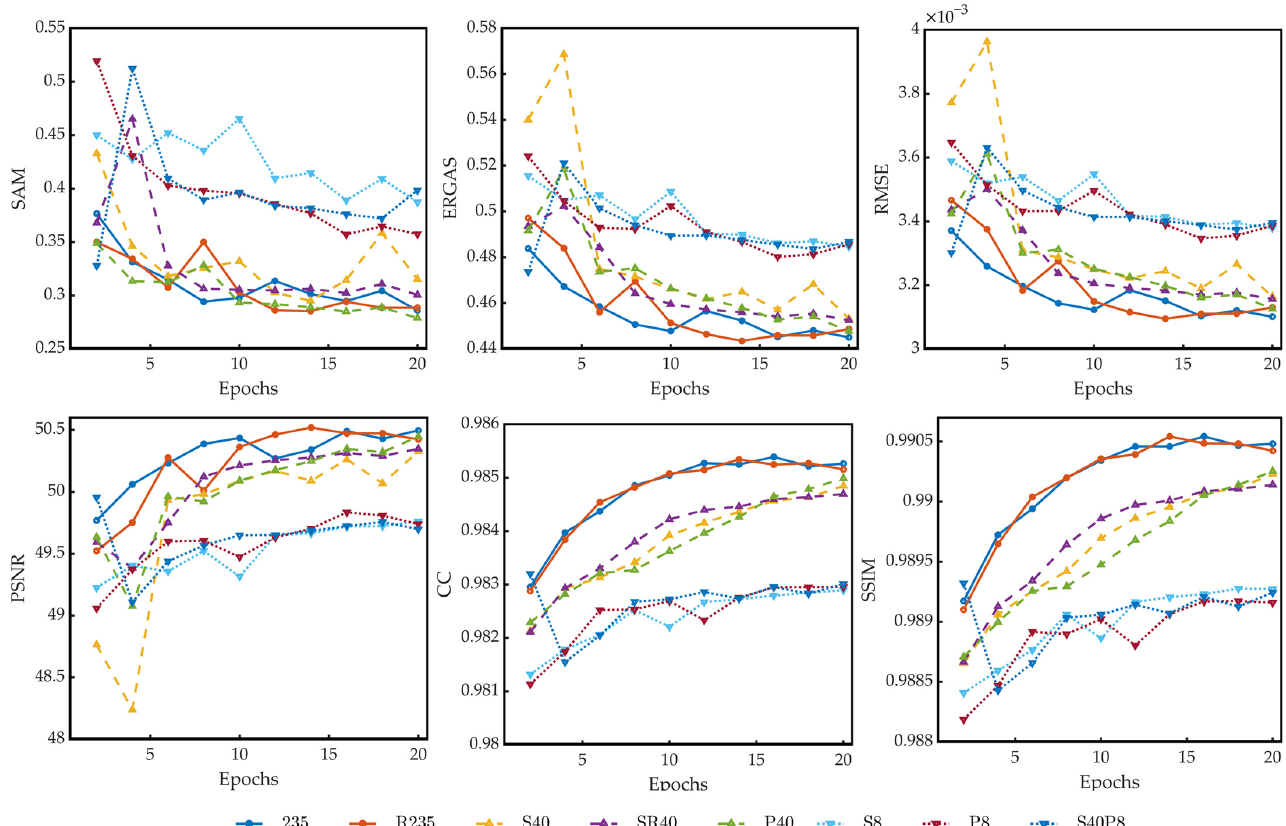
Figure 5. The performance of models trained on different datasets under different epochs. SAM(Spectral Angle Mapper), ERGAS(Erreur Relative Globale Adimensionnelle de Synthèse), RMSE(Root Mean Squared Error), PSNR(Peak Signal-To-Noise Ratio), CC(Cross-Correlation), and SSIM(Structural Similarity Index Measure are used for the performance evaluation.